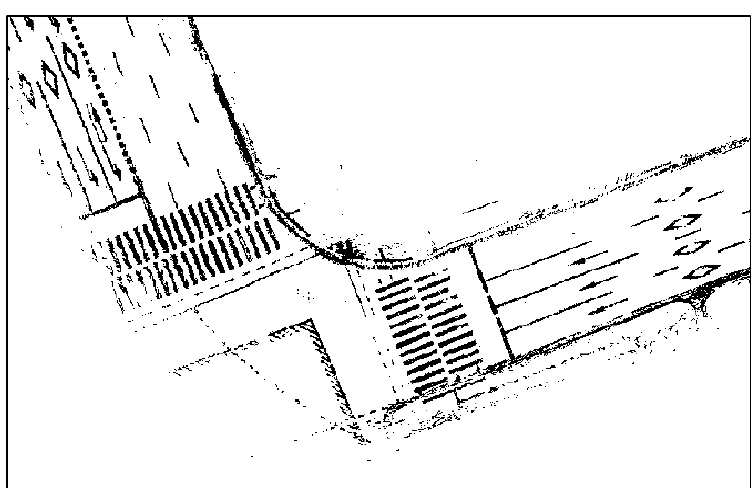
Figure 8. Binarized road reflectivity map.